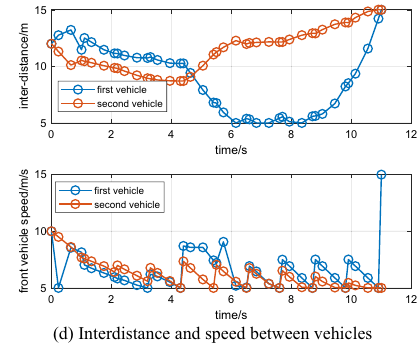
Figure 6. ( a – d ) The driving states of AEVPs in two driving